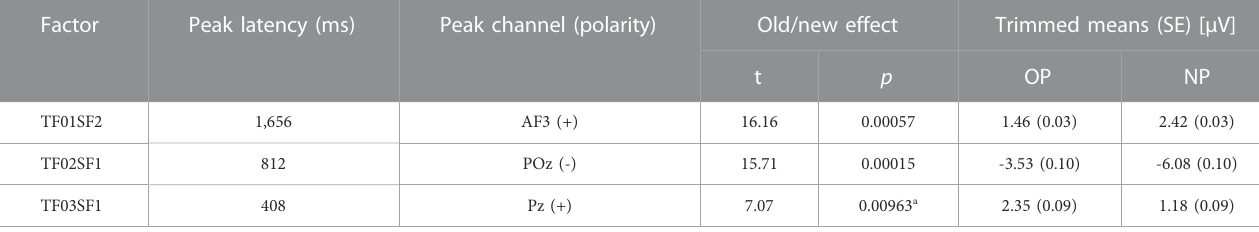
TABLE 4 Temporospatial factors (ERP components) with old/new effect selected for main analysis.